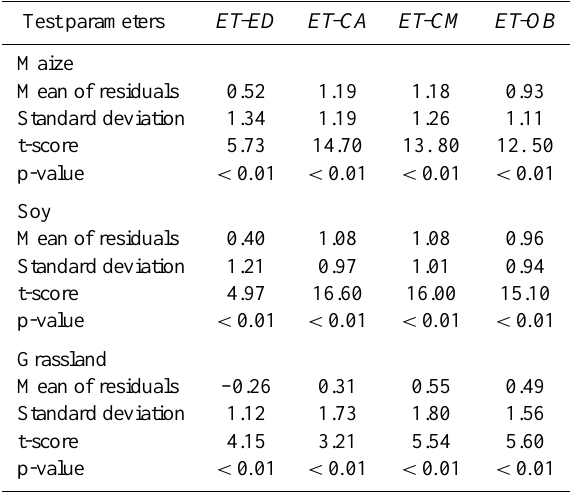
Table 1. Arrangement of vegetation types, locations, and years. Vegetation Location Year of the cover type growing season